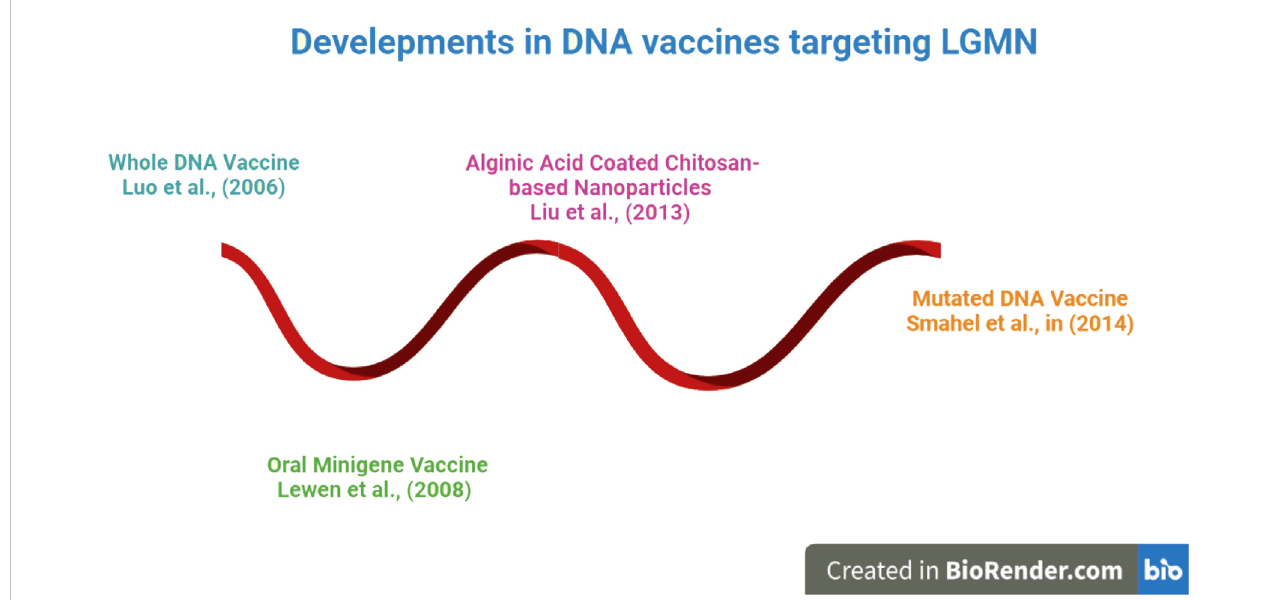
FIGURE 3 An Overview of DNA Vaccines against LGMN. Research has shown that work on DNA vaccinations began in earnest in 2006. DNA vaccines have been engineered in a variety of forms, from whole DNA to altered DNA enclosed in a nanoparticle. Later on! DNA vaccines experienced got tremendous development, proven to be successful at lowering tumor burden and concentrating on